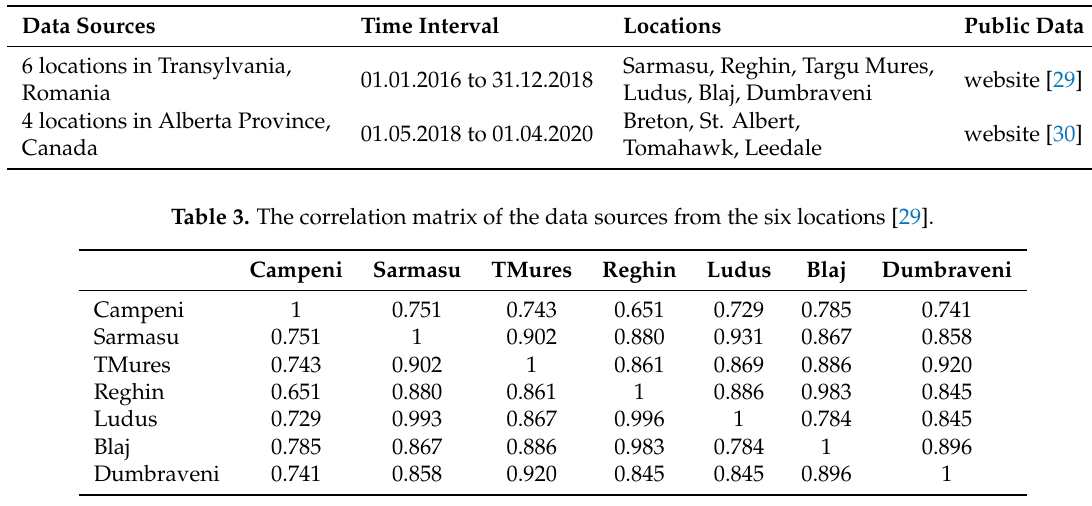
Table 2. Overview of Data Sources with details about considered Time interval (time series), the name of locations from Data Sources and where to find data on public websites.